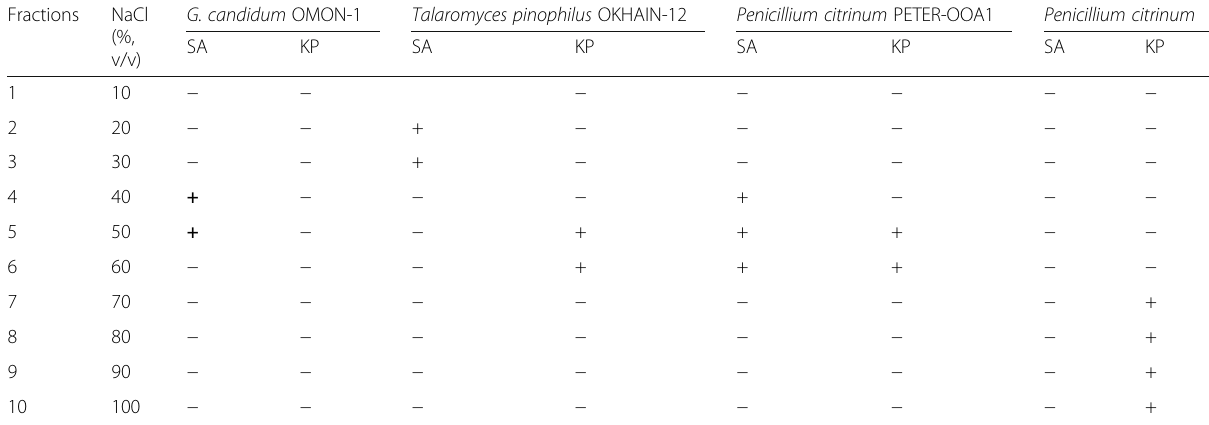
Table 3 Bioactivity of fractions of G. candidum OMON-1, T. pinophilus OKHAIN-12, P. citrinum PETER-OOA1, and P. citrinum MASTER- RAA2 antimicrobial extracts separated using ion-exchange chromatography